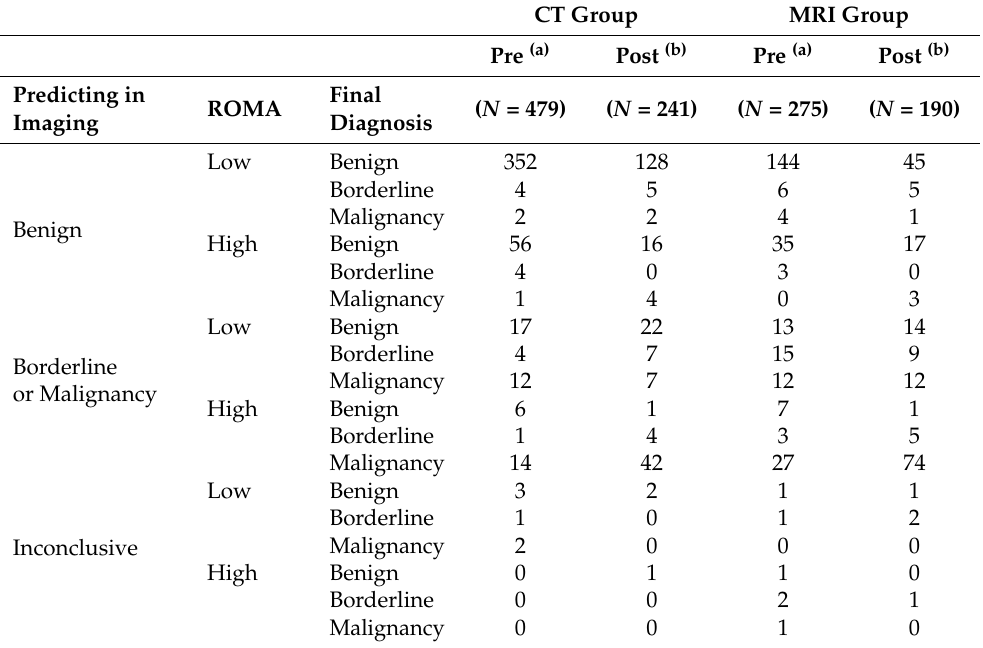
Table 2. Predicting in imaging and ROMA in premenopausal and postmenopausal patients with ovarian